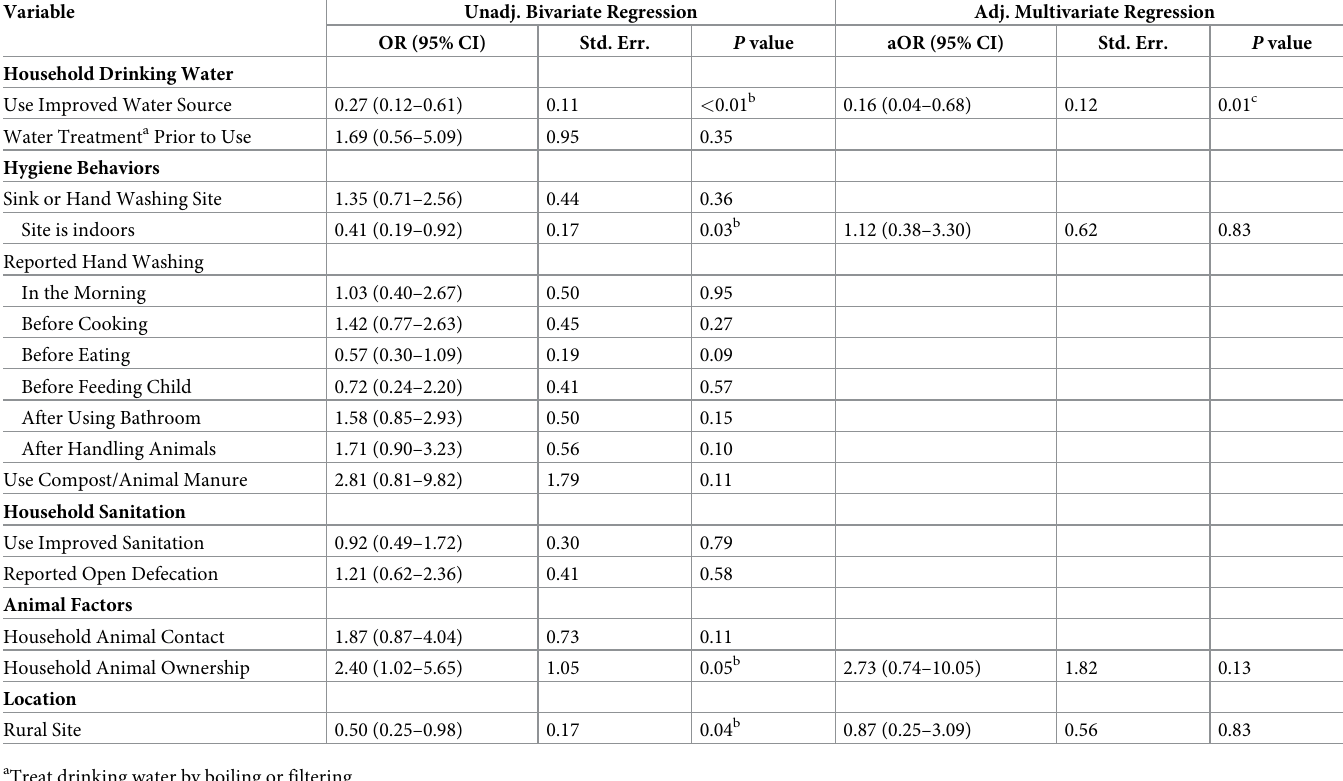
Table 4. Bivariate and multivariate analysis of the association between household risk factors and the presence of Cryptosporidium spp . and/or Giardia duodenalis in humans, animals, and the